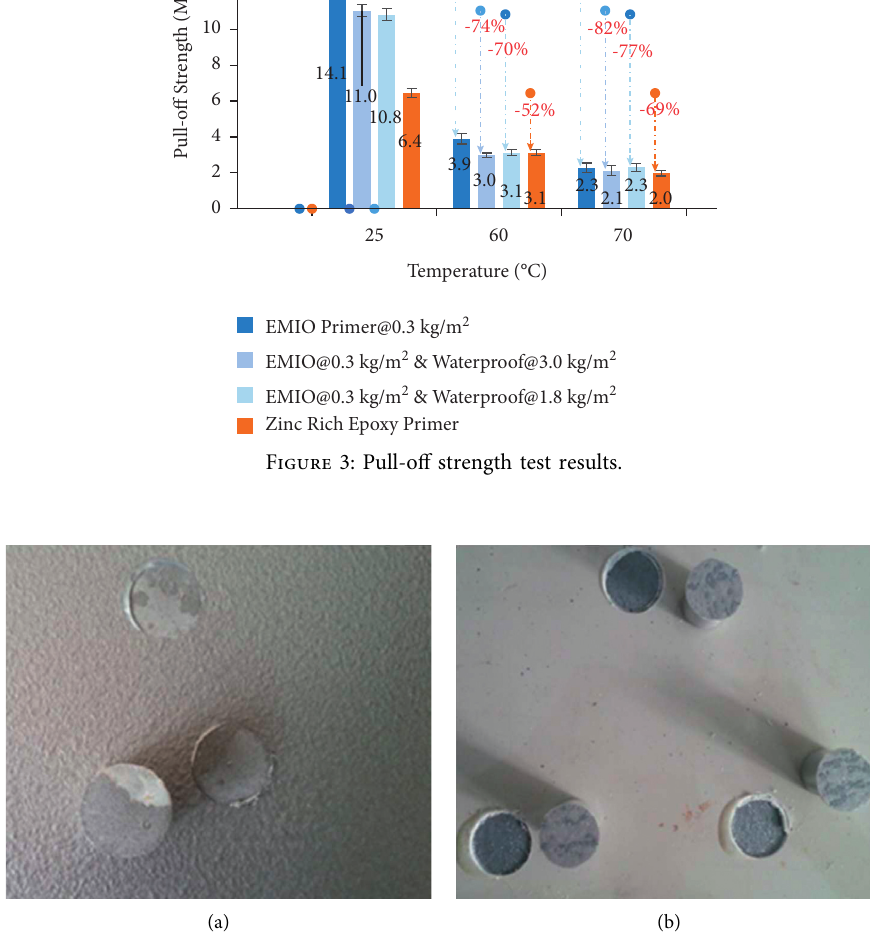
Figure 4: Failure photos of pull-off tests. (a) Failure at EMIO-steel interface (25 ° C). (b) Failure at waterproof-EMIO interface (25 ° C, 3.0 kg/ m 2